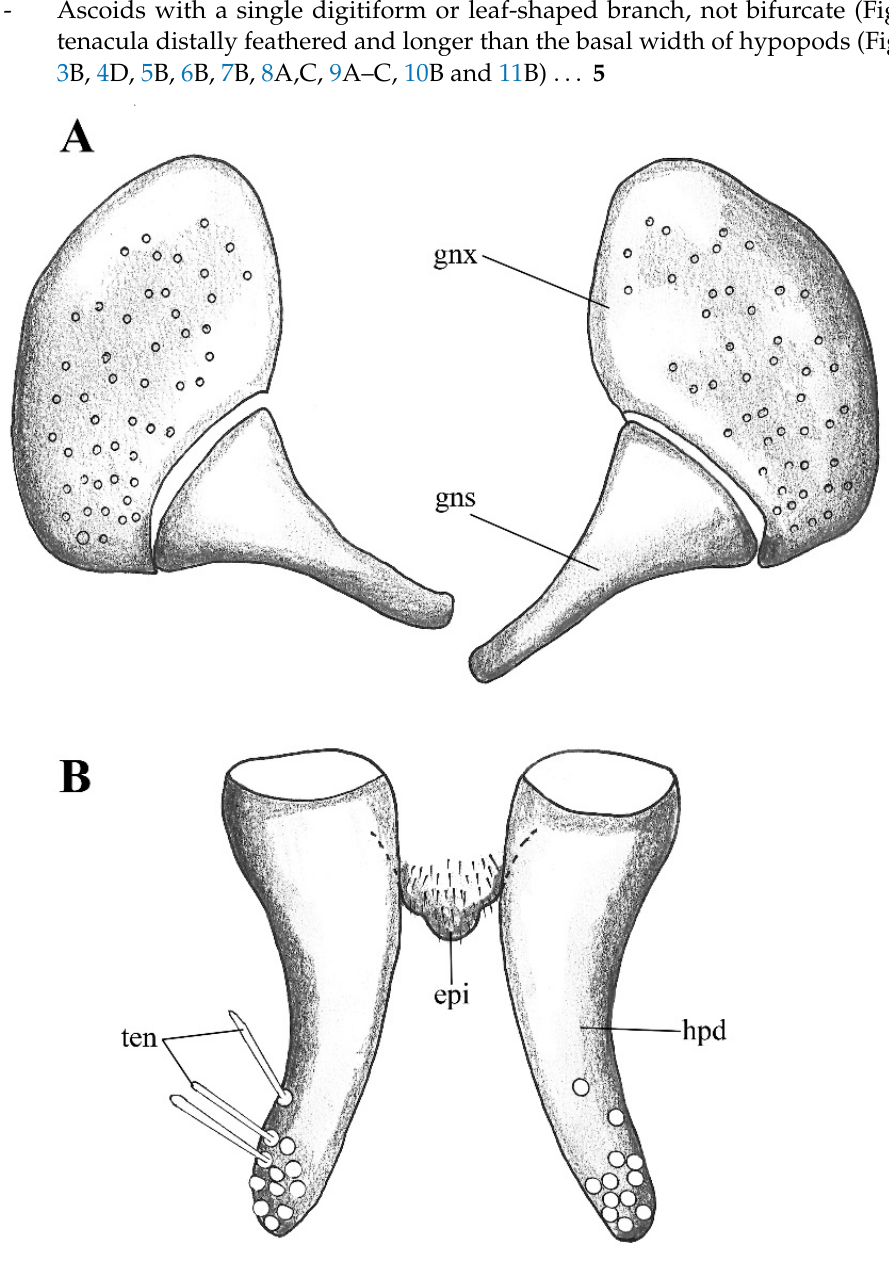
Figure 2. Lepiseodina latipennis (Sar à 1953), male genitalia adapted from the original de- scription by Sar à (1953). ( A ). Gonocoxites and gonostyli. ( B ). Hypopods and